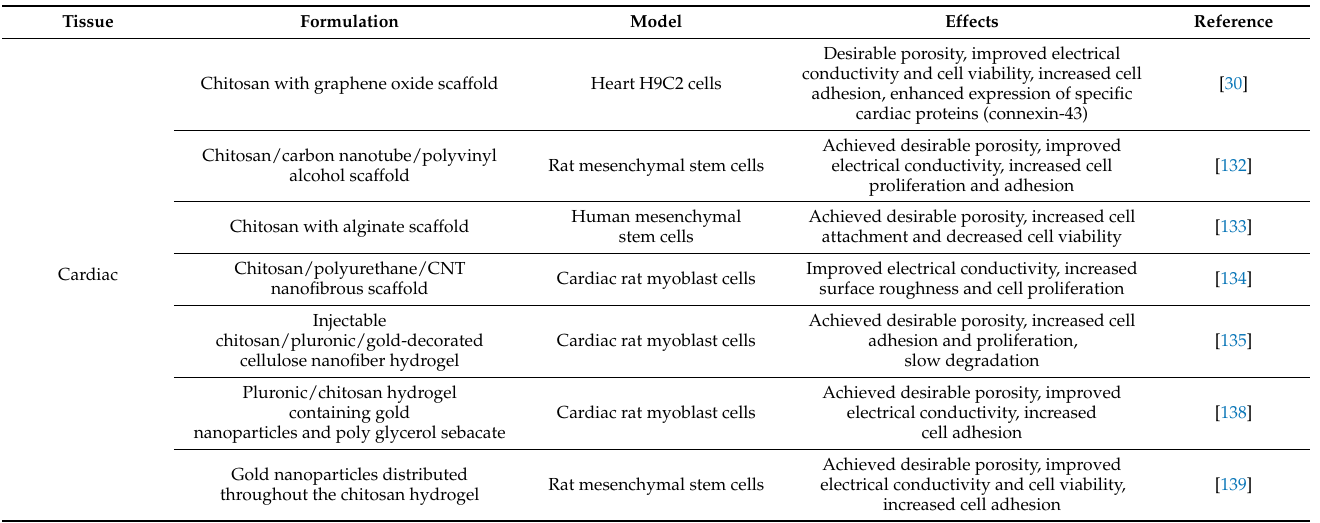
Table 2. Use of Different Chitosan Formulations for Cardiac and Nervous Tissue Regeneration.